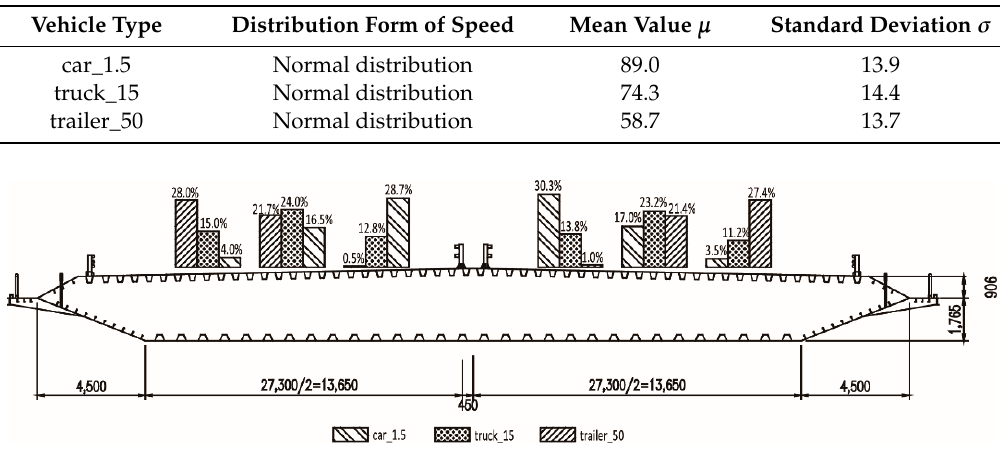
Figure 13. Distribution proportion of the three typical vehicle types.